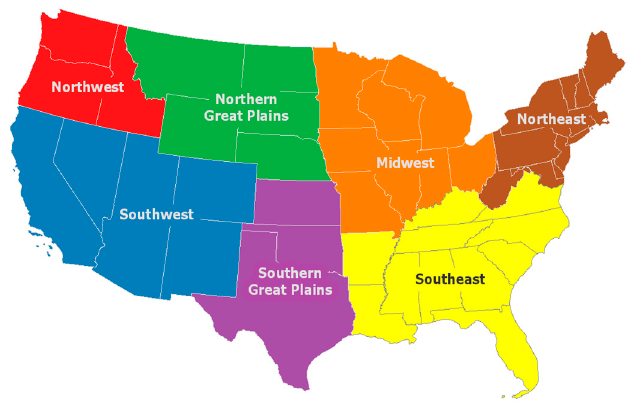
Figure 1. Results for this study were summarized by National Climate Assessment regions.